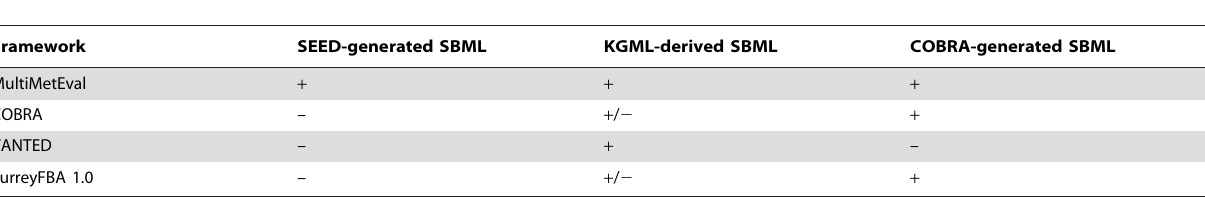
Table showing SBML parsing abilities of the most popular FBA tools. Only the MultiMetEval parser is able to successfully process SBML models from SEED [11,28], KGML [29] and COBRA